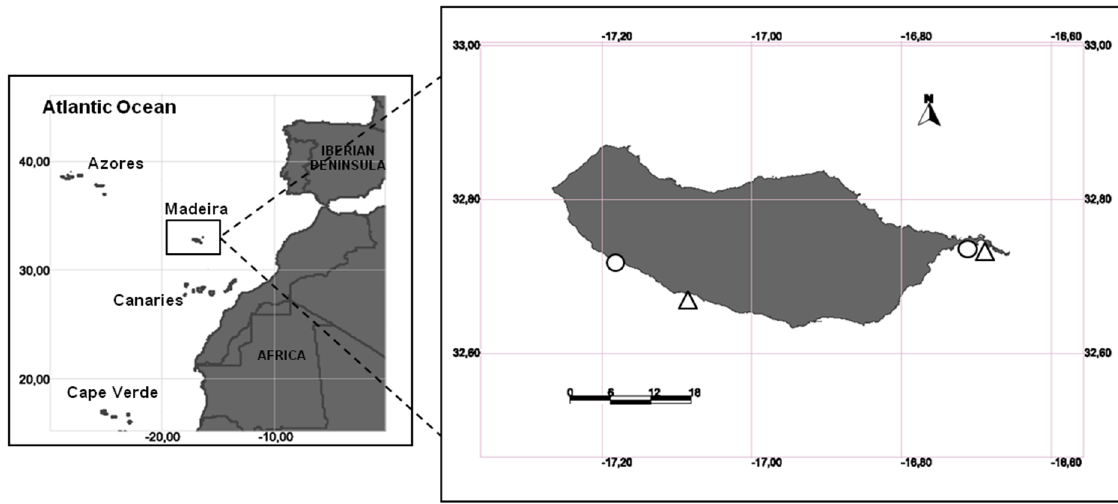
Figure 1. Study regions in Madeira along the southern coast. Triangles, aquaculture facilities; circles, marinas.